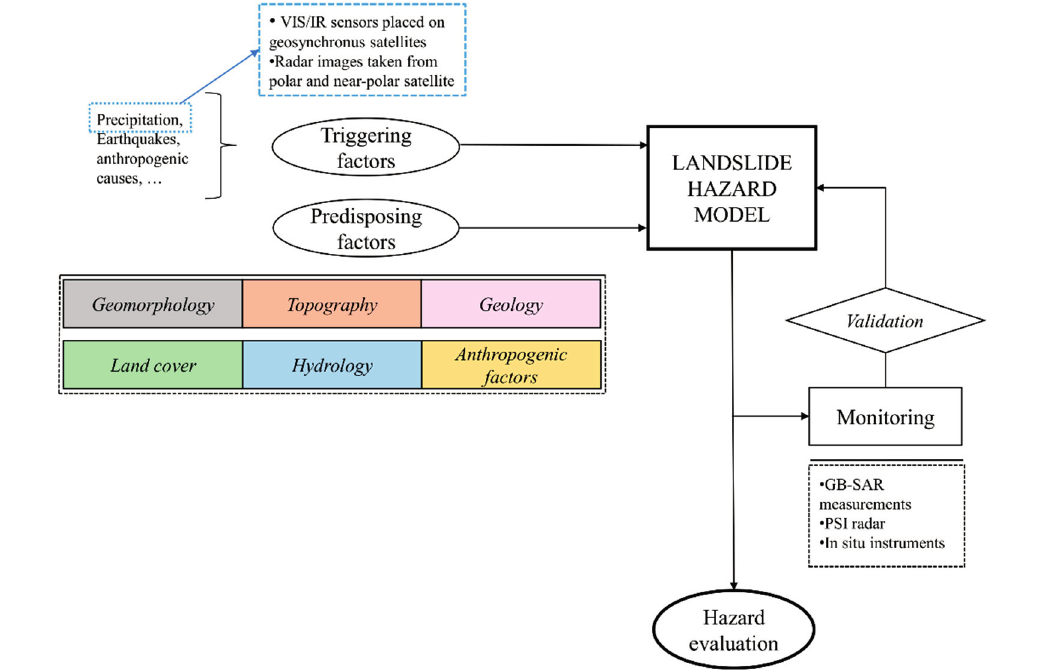
Figure 3. Landslide hazard evaluation process.